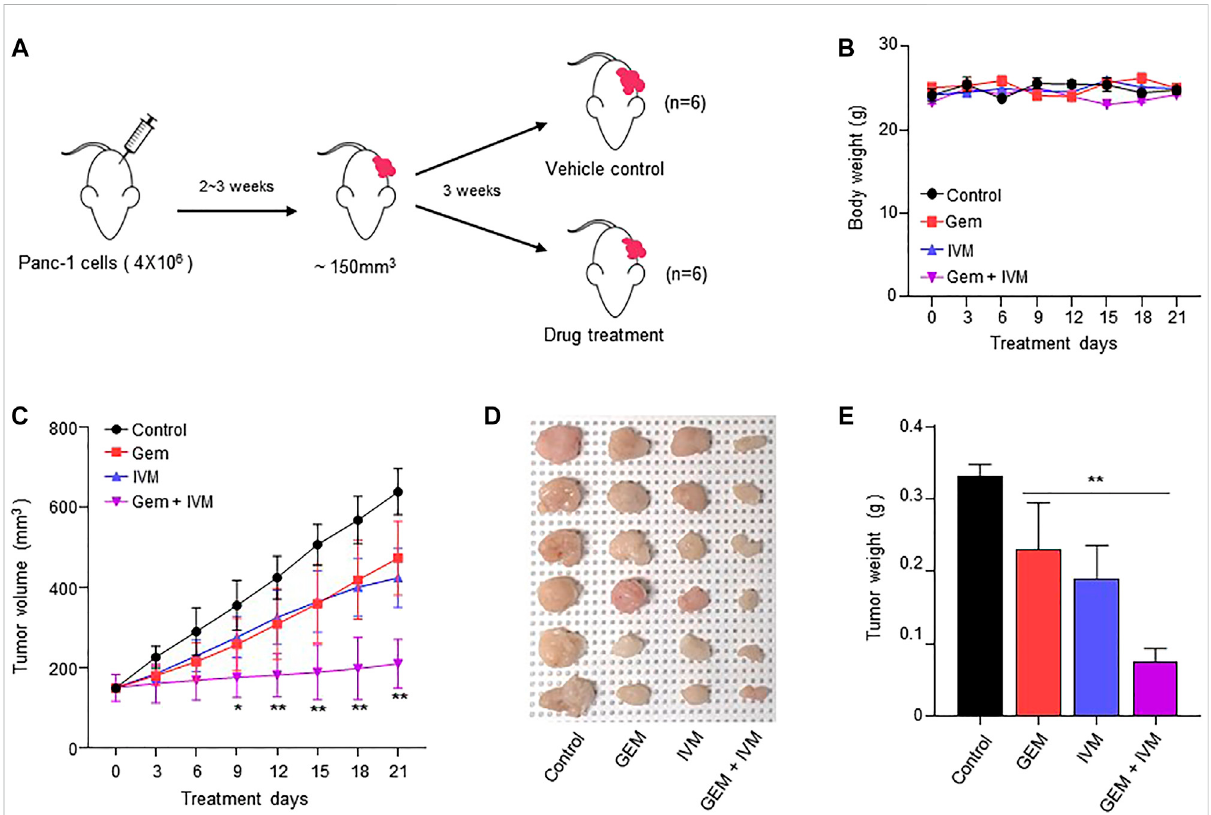
FIGURE 5 Combination of ivermectin and gemcitabine synergistically inhibits the tumor growth in vivo . (A) BALB/c nude mice were xenografted with PANC-1 cells (4 × 10 6 cells). Then, the mice were intraperitoneally injected with dimethyl sulfoxide (DMSO) or gemcitabine (10 mg/kg) or ivermectin (5 mg/kg)twiceaweekfor21 days. (B) Micebodyweights. (C) Tumorvolumewasmeasuredevery3 days.Datarepresentsthemean±SD( n =6).* p < 0.05 and ** p < 0.01 compared with the gemcitabine alone group. (D) Representative image of tumors on day 21. (E) Tumor weights. Data represents the mean ± SD ( n = 6). * p < 0.05 and ** p < 0.01 compared with the gemcitabine alone